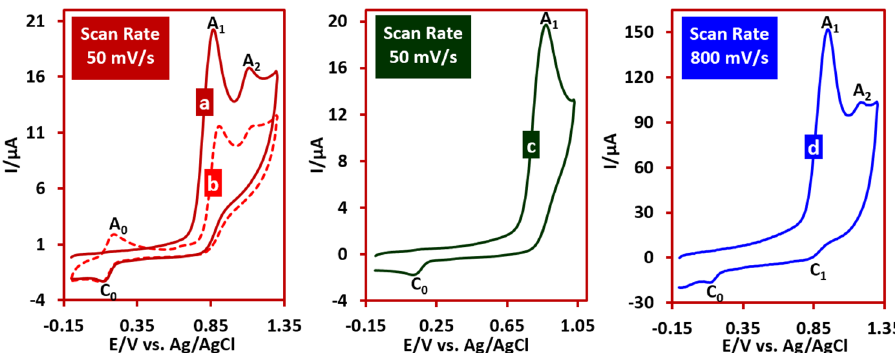
Figure 2. Curves (a, b) First and second cyclic voltammograms of IMP (1.0 mM) at glassy carbon electrode in water (acetate buffer, c = 0.2 M, pH 5.0), at room temperature. Curve © is similar to curve a, but with a more limited potential range. Curve (d) is similar to curve a, but at scan rate of 800 mV s −1